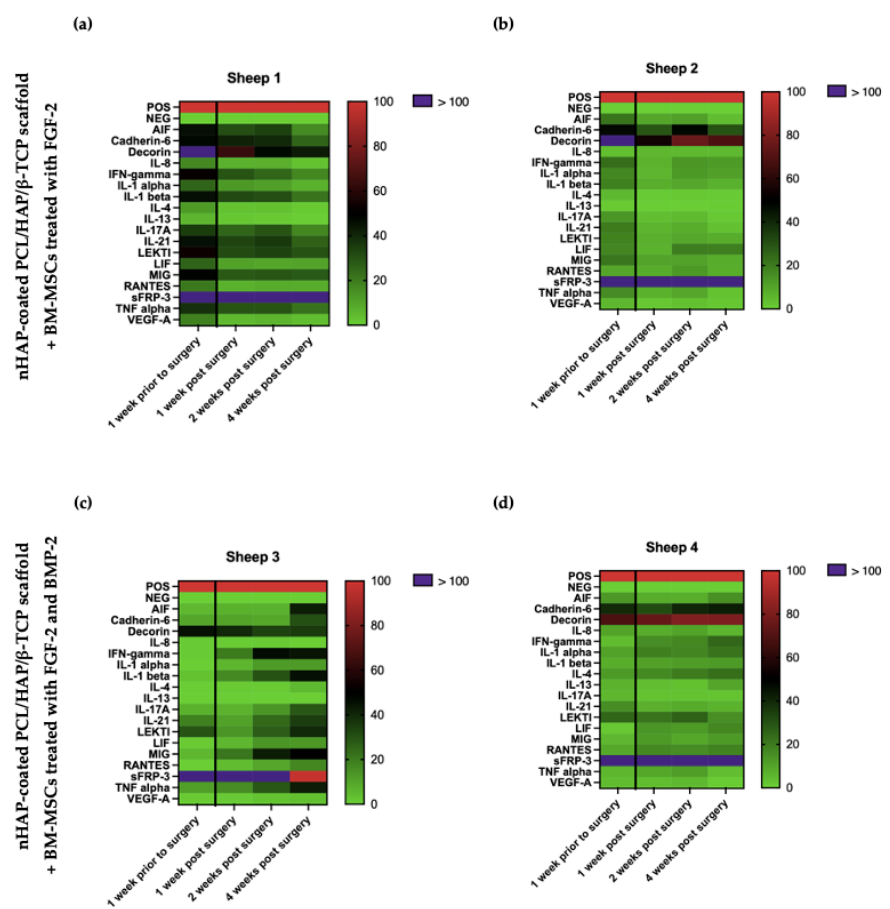
Figure 11. Cytokine profiles of sheep serum 1 week before and 1, 2, and 4 weeks after the transplan- tation of an nHAP-coated PCL/HAP/β -TCP scaffold and BM-MSCs treated with FGF-2 ( a , b ) and FGF-2 combined with BMP-2 ( c , d ).